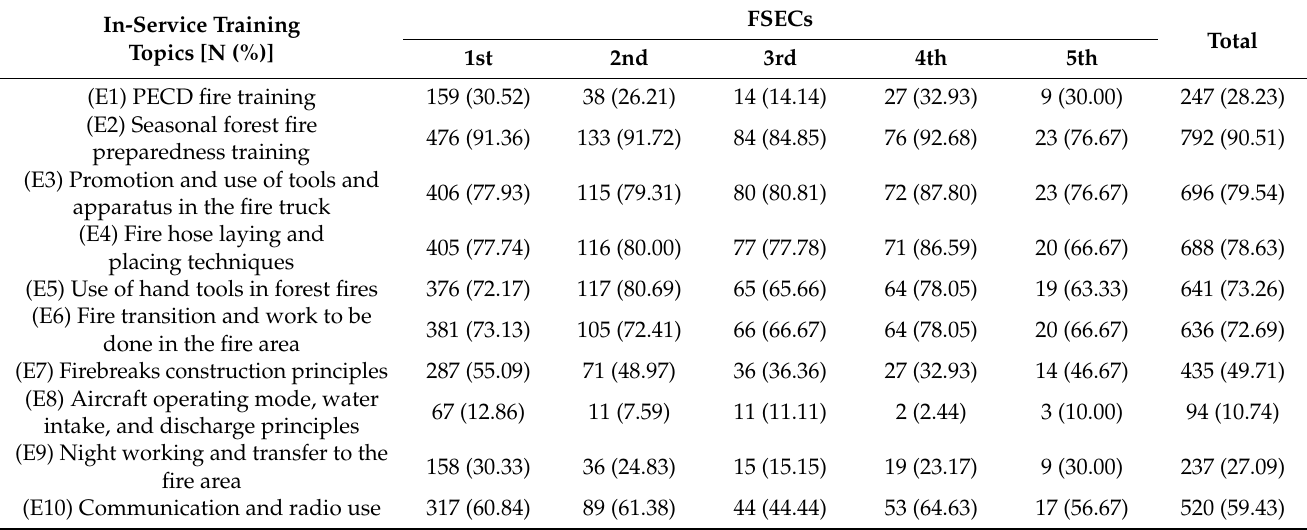
Table 5. In-service training topics for FFFs and their participation